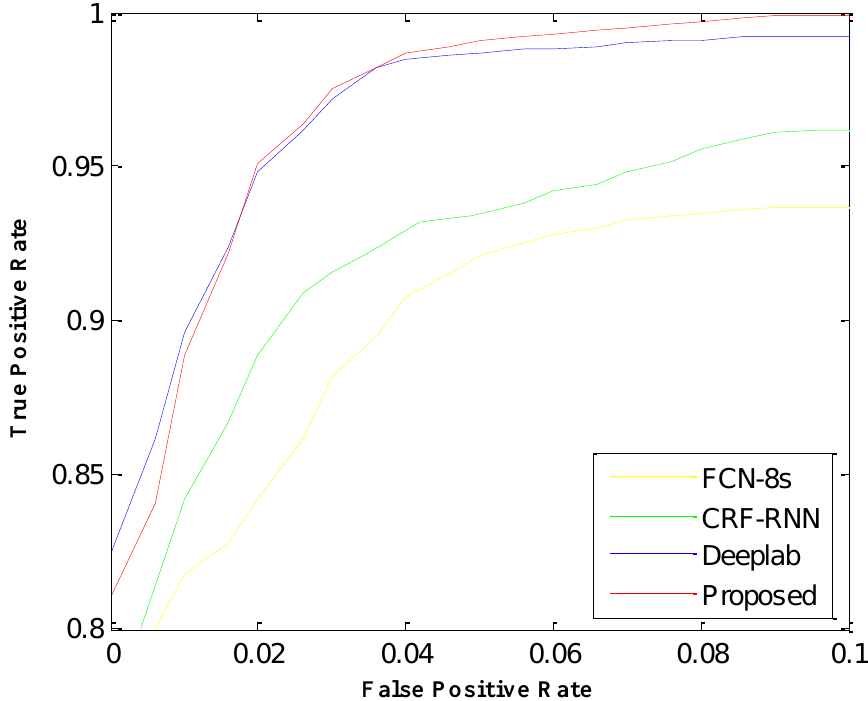
Figure 11. Receiver operating characteristic (ROC) curve analysis of the four methods.